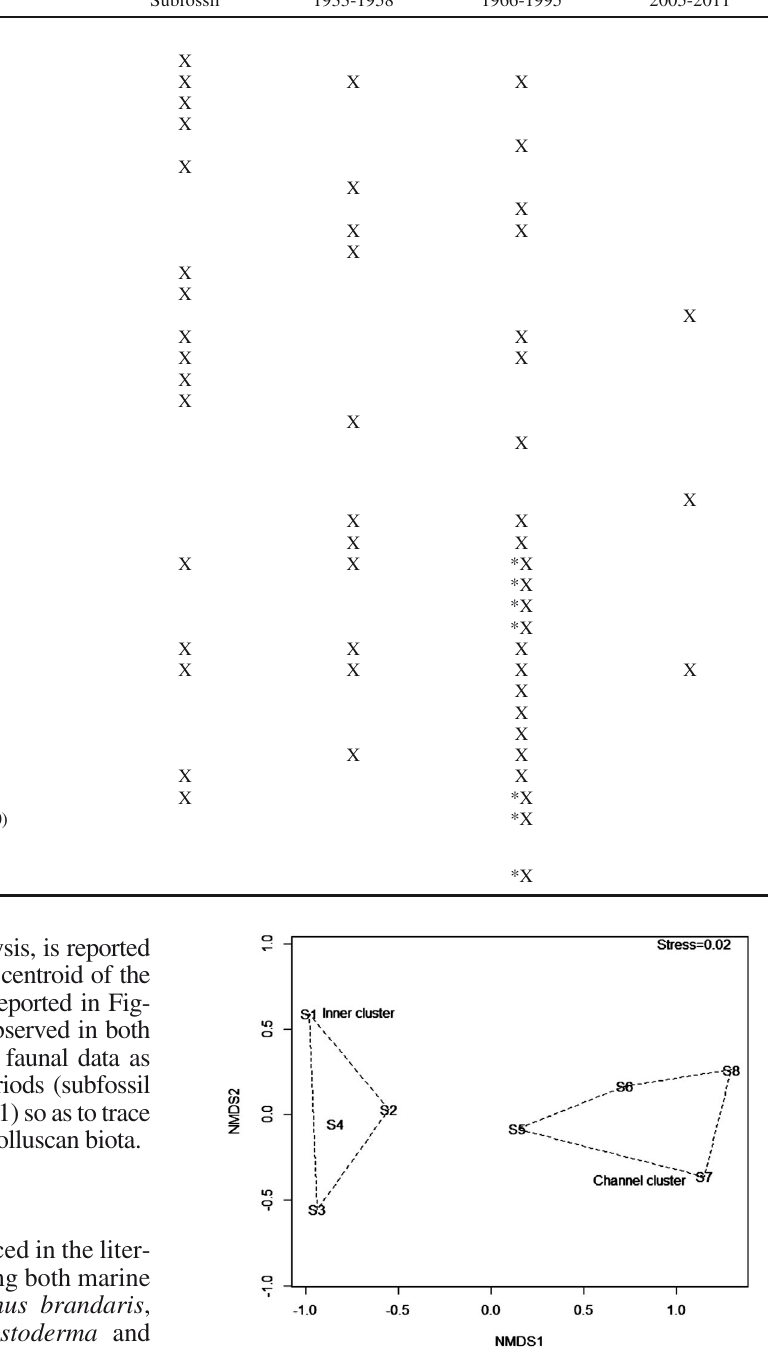
Fig. 3. Non-metric multidimensional scaling plot showing the ordination of the sites as well as the groups identified by cluster analysis: Inner and Channel